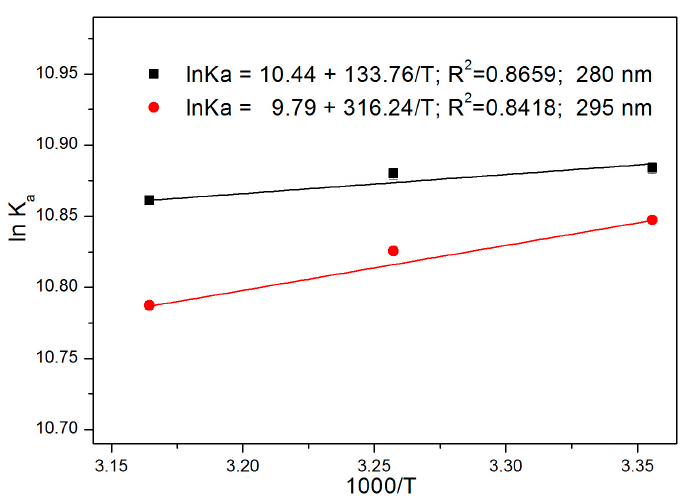
Figure 6. Van’t Hoff plots for the ATR ‐ HSA systems.